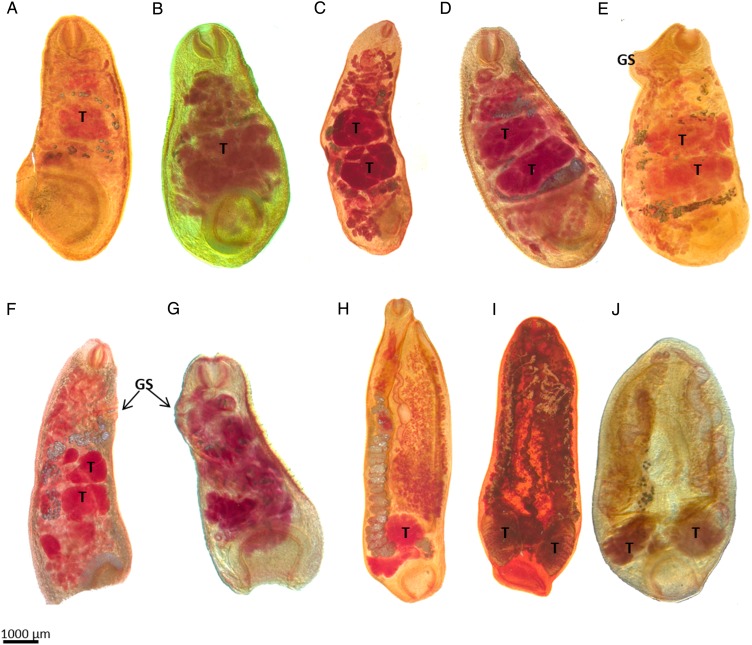
Sections of adult paramphistomoids collected from domestic ruminants in Kenya and
their provisional identifications. (A) Calicophoron phillerouxi,
(B) Calicophoron raja, (C) Calicophoron clavula,
(D) Calicophoron microbothrium, (E) Cotylophoron
sp., (F) Cotylophoron cotylophorum, (G)
Cotylophoron sp., (H) Carmyerius exporous, (I)
Carmyerius gregarius, (J) Carmyerius mancupatus.
Note that the photographed specimens represent sections of adults, and presence of
some organs like the testes (T) or genital sucker (GS) are indicated. For the genus
Carmyerius, a ventral pouch was present, but is not visible in
the sections chosen for presentation.